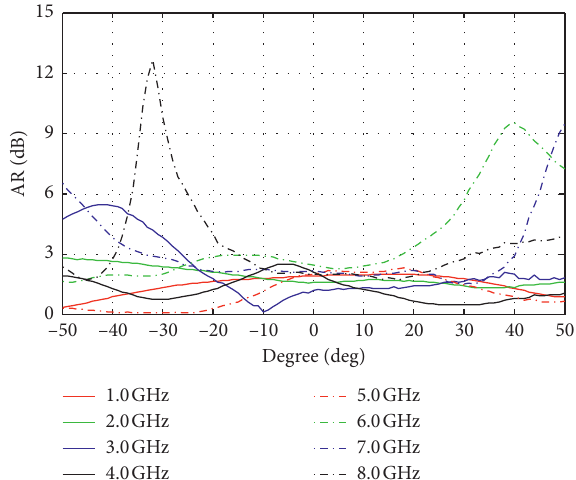
Figure 26: The ARs at different angles.